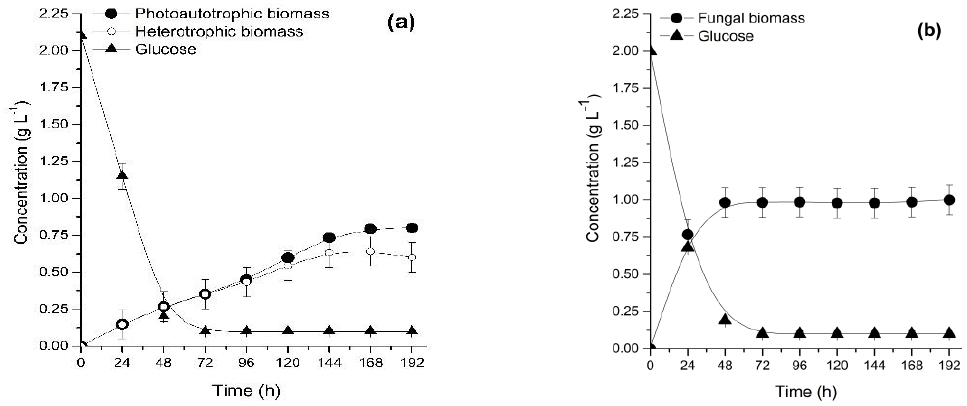
Figure 1. Growth curve of C. vulgaris ( a ) and M. circinelloides ( b ) on medium A.